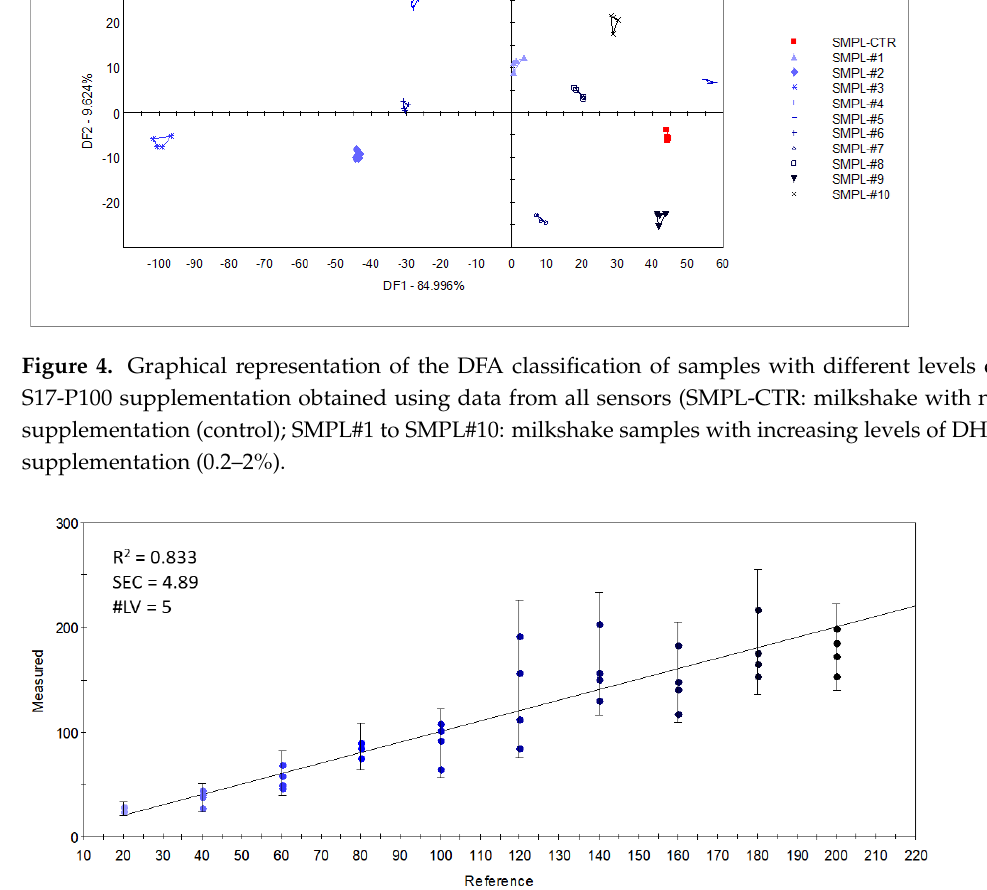
Figure 5. Y-fit of the PLSR calibration on the S17-P100 concentration (mg/in 10 g product) using data from all sensors (R 2 : determination coefficient; SEC: standard error of calibration; #LV: number of latent variables); the intensity of the colors from light blue to black along the Y-fit line represents the increase in concentration levels of the DHA supplementation.